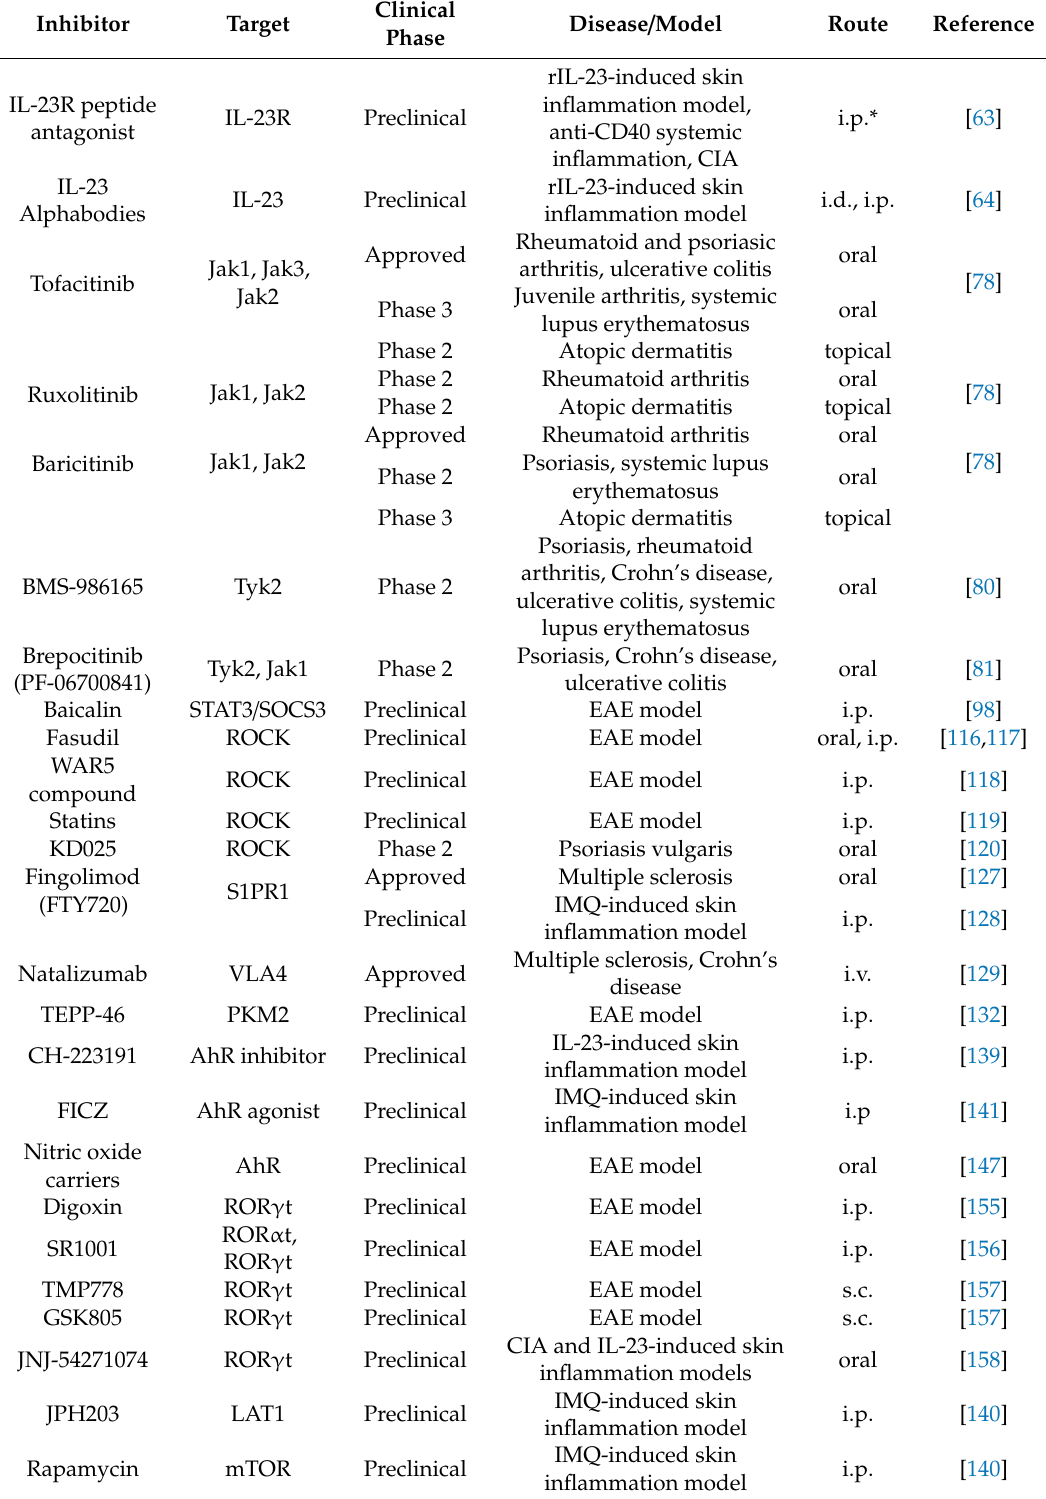
Table 1. Selected small molecule inhibitors, drugs, and protein sca ff olds that interfere with IL-23 signaling